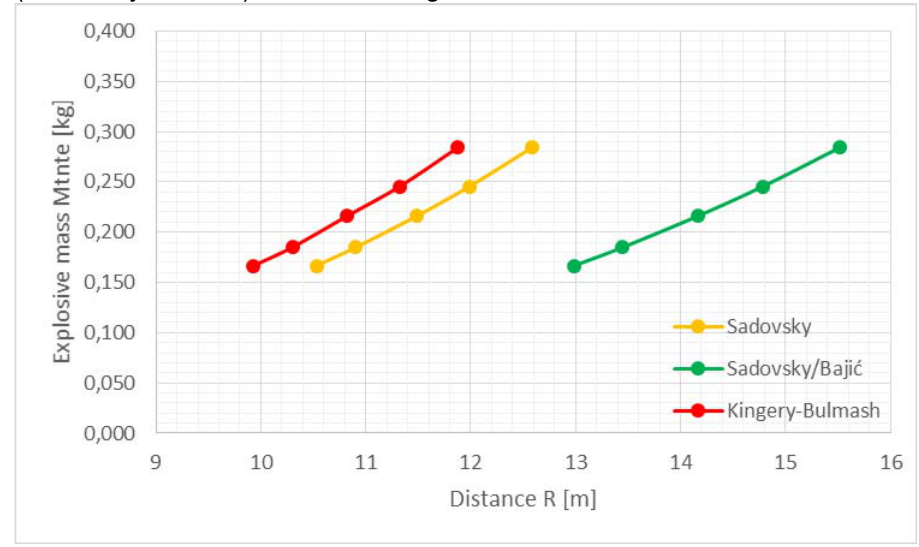
Figure 3 – Critical distance as a function of pressure Рис . 3 – Критическое расстояние в зависимости от давления Слика 3 – Критично растојање у зависности од